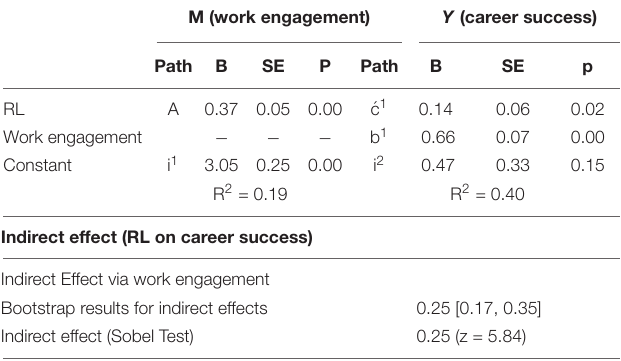
TABLE 4 | Mediation results.